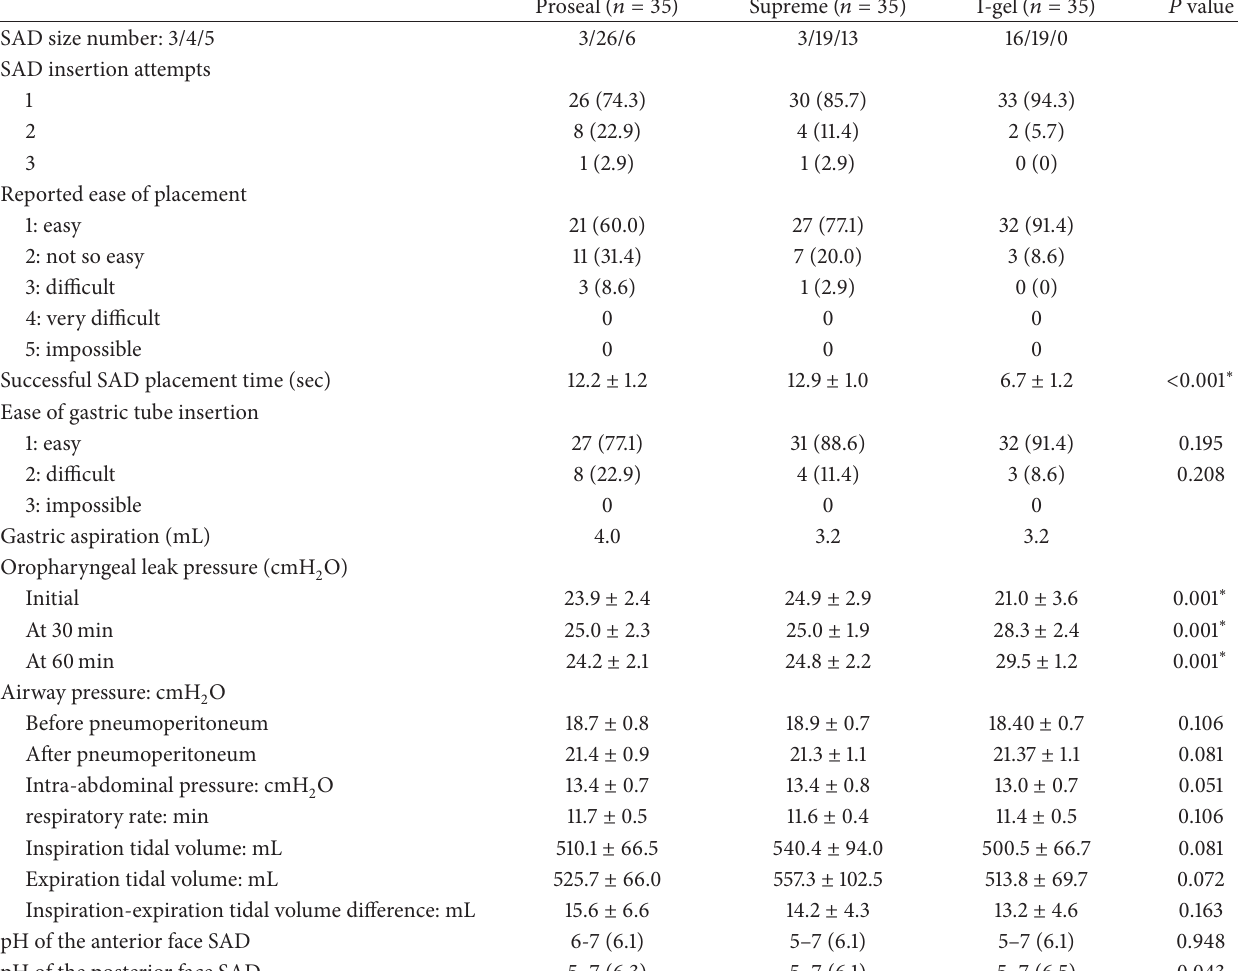
Table 2: Airway insertion characteristics, oropharyngeal leak pressure, and ventilatory parameters of each group. Proseal (𝑛 = 35)